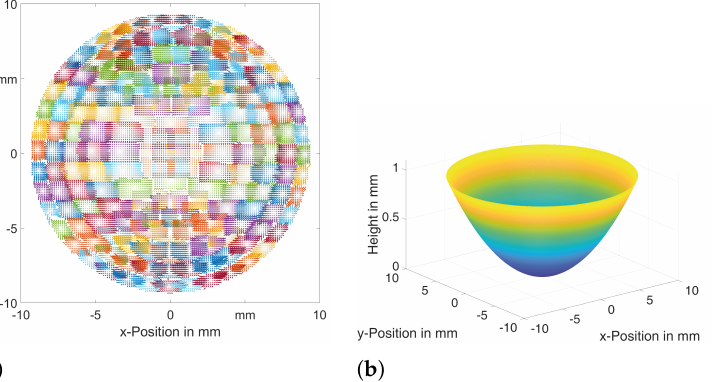
Figure 7. Measurement results for an aspheric lens as the surface under test: ( a ) An aggregate of wave vectors extracted from the measured coherence function. Different colors indicate light from different light sources. ( b ) Calculated profile of the lens after 2000 iterations of the inverse ray-tracer. Reprinted with permission from Reference